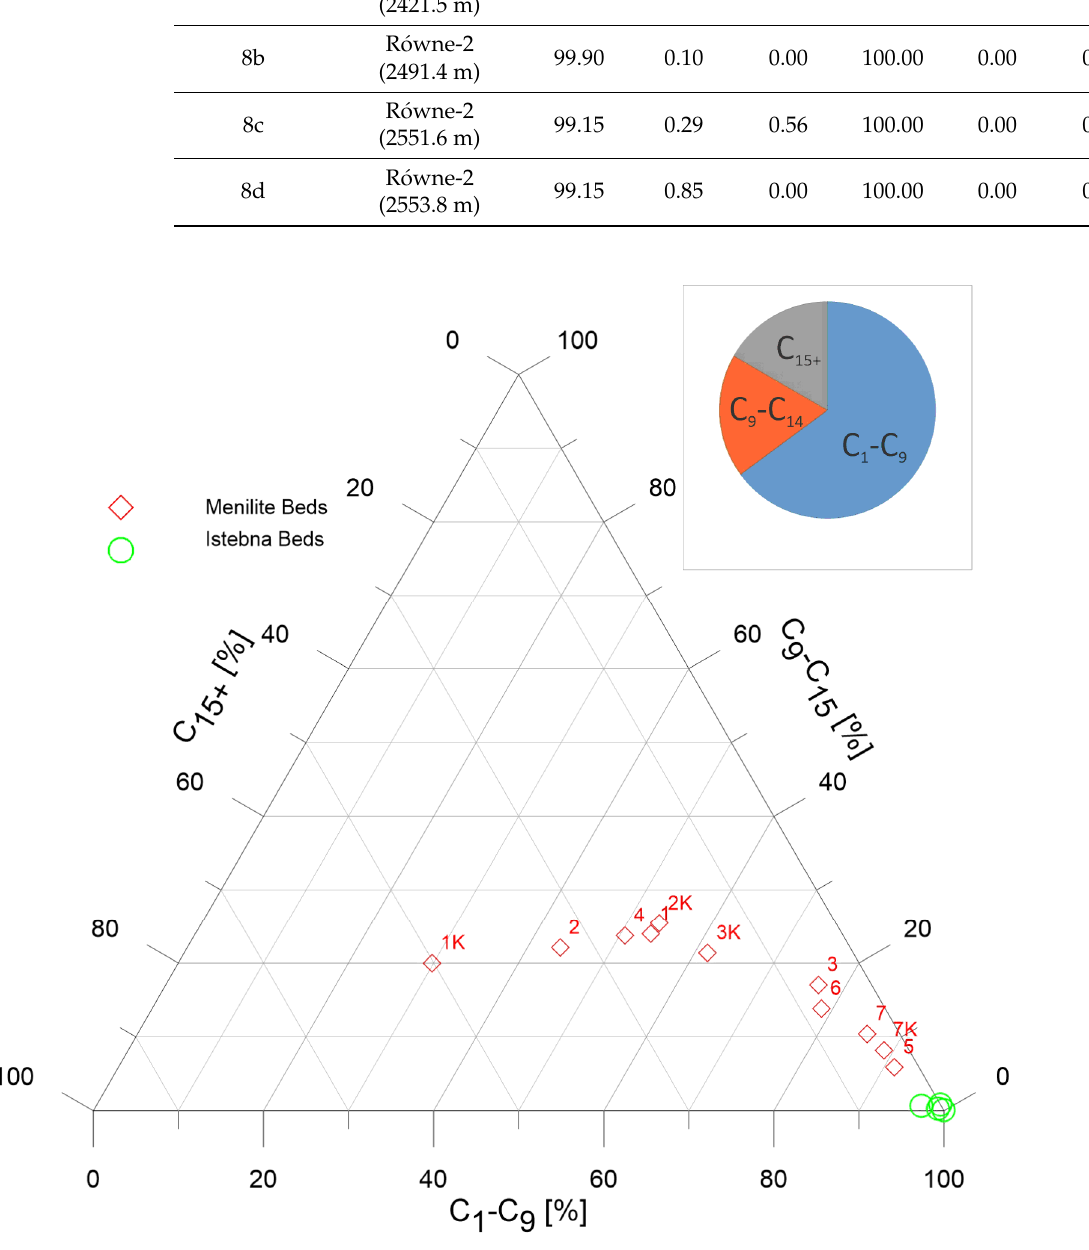
Figure 16. Distribution of hydrocarbon fractions generated through Py/GC at 300–650 °C, using the example of Sample 9 from the Istebna Beds.